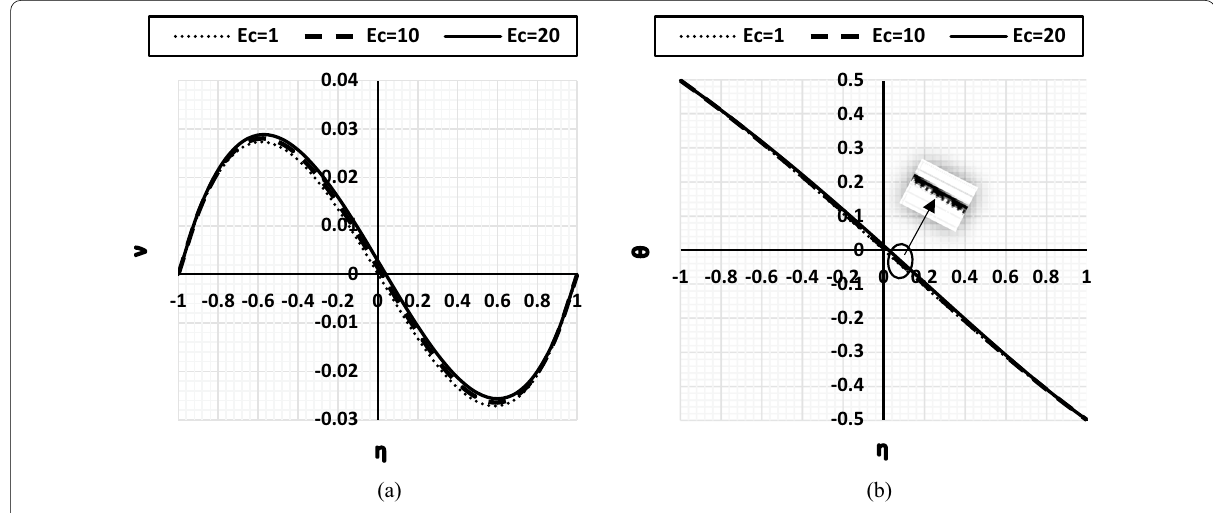
Fig. 4 Result of V ( η ) and θ ( η ) for various Ec when ϕ